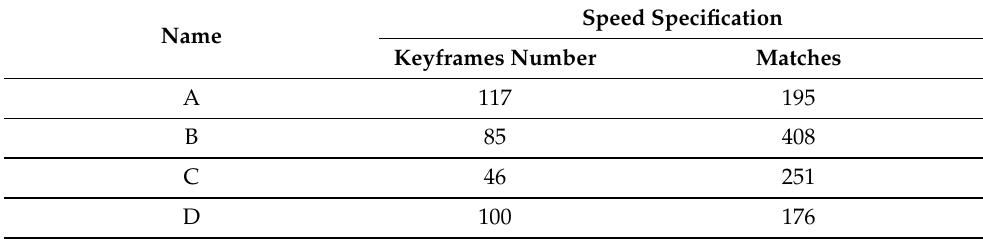
Table 2. The map building throughput of the proposed system.